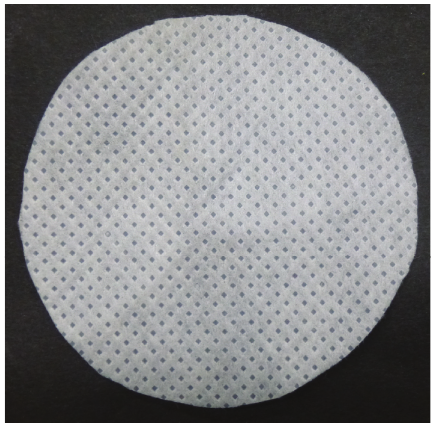
Figure 1: Circular piece of spunbond polypropylene fabric (5cm diameter) used as filter medium for TiO 2 nanoparticles precoat filtration with PAC.